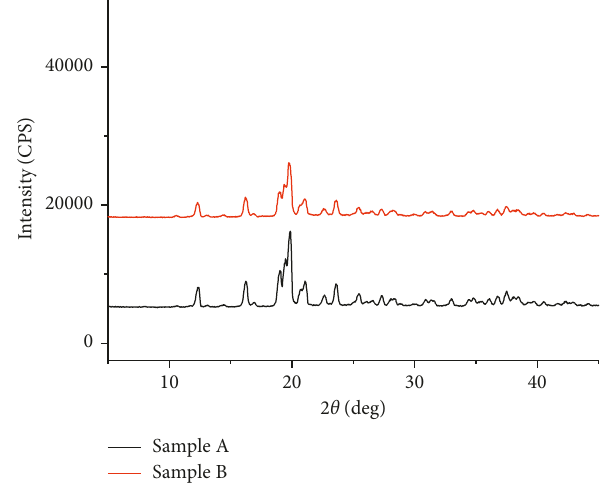
Figure 5: XRD curves of the two spray-dried